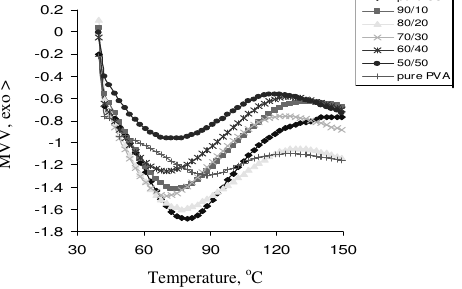
Figure 3. The DSC first run curves of CS/PVA blended